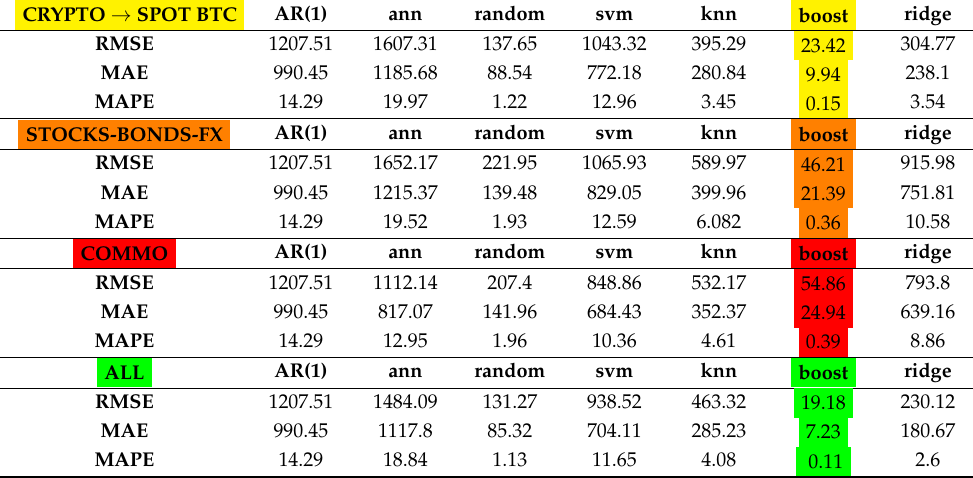
Table 3. Full sample forecasting results for the Coinbase Bitcoin spot